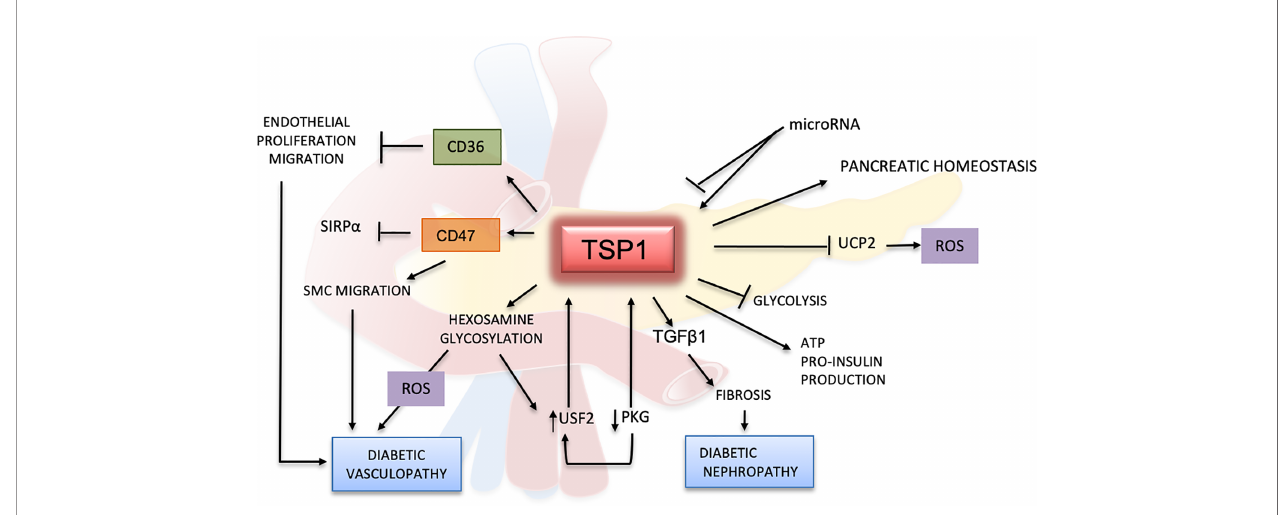
FIGURE 3 | Effects of TSP1 and ligands in glucose metabolism and diabetes mellitus. TSP1 protects the pancreatic endothelium and controls angiogenesis by enhancing insulin production and release. TSP1 also blocks the formation of uncoupling protein 2 (UCP2), a mitochondrial protein involved in oxidation and reactive oxygen species (ROS) metabolism. Under normal glycemic conditions, TSP1 inhibits glycolysis promoting the production of more ATP and pro-insulin. However, under hyperglycemic conditions and by activating TGF b 1, TSP1 accelerates the in fl ammation and fi brotic changes in multiple organs, especially in the kidney, leading to diabetic nephropathy and other diabetic complications. The TSP1 receptors CD36 and CD47 can inhibit the proliferation and migration of endothelial and smooth muscle cells, thereby contributing to endothelial dysfunction in diabetes. In this context, CD47 regulates SMC migration by binding mainly to TSP1 while limiting its association with SIRP1 a . Activation of the hexosamine pathway and glycosylated products can induce further endothelial damage, with generation of ROS and delay of the wound-healing process in diabetes. Hyperglycemia will inhibit PKG and induce upstream stimulatory factor 2 (USF2), promoting the upregulation of TSP1 in diabetes. However, all these effects mediated by TSP1 in the glucose metabolism may be regulated by